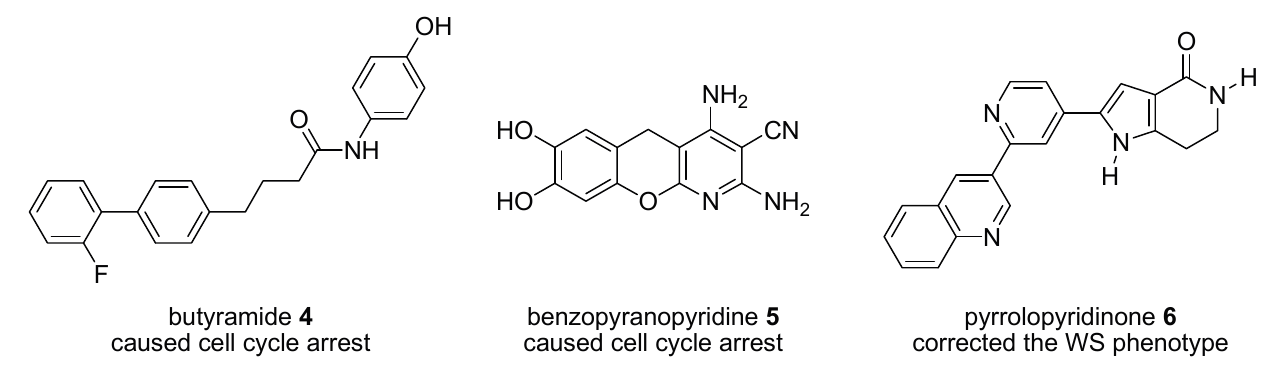
Figure 3. MK2 inhibitor chemotypes and their effect on WS cells.